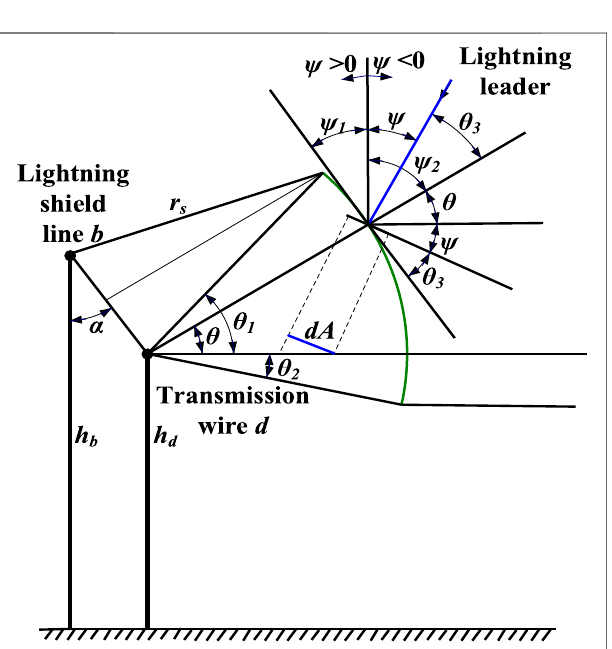
FIGURE 3 | Diagram of the EGM model calculation